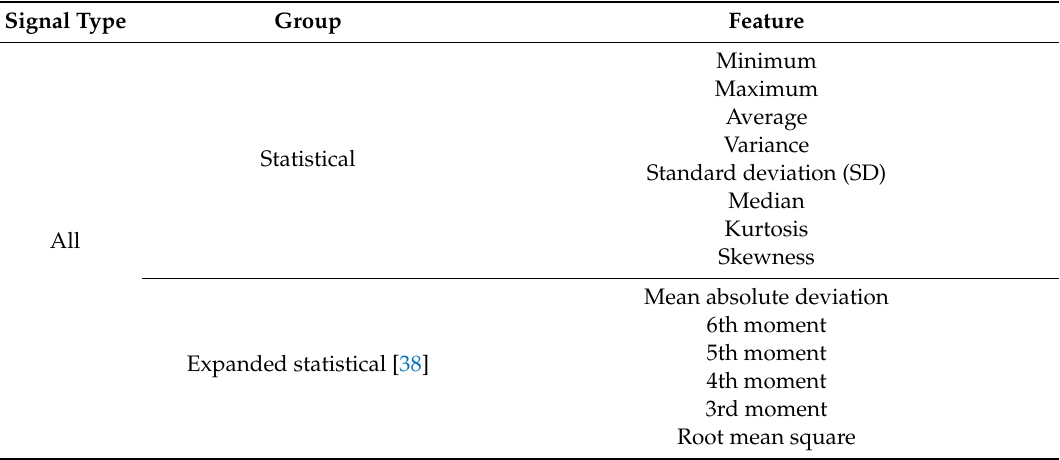
Table 1. Feature set of physiological